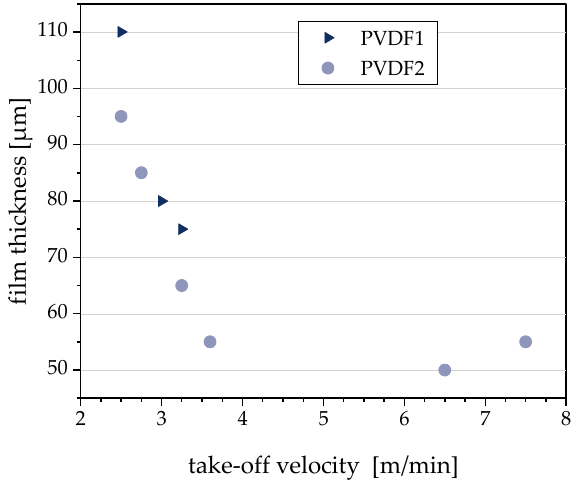
Figure 7. Film thickness in dependence on take-off velocity during film extrusion for PVDF/1 wt % b- MWCNTs + 3 wt % CB composites.